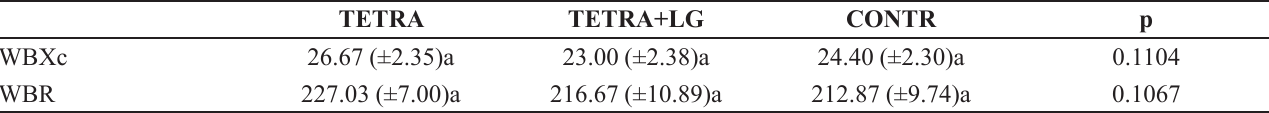
WBXc – Whole-body reactance; WBR - Whole-body resistance; TETRA – Tetracycline group (75 mg/kg/day); TETRA+LG – Tetracycline plus L.gasseri group (75 mg/kg/day plus 10 9 cfu); CONTR – Control group; Different superscripted letters, in same row, indicate statistical significance p <0.05. TABLE III - BMI, Lee index, AC/TC ratio, TBW, and BW in all groups